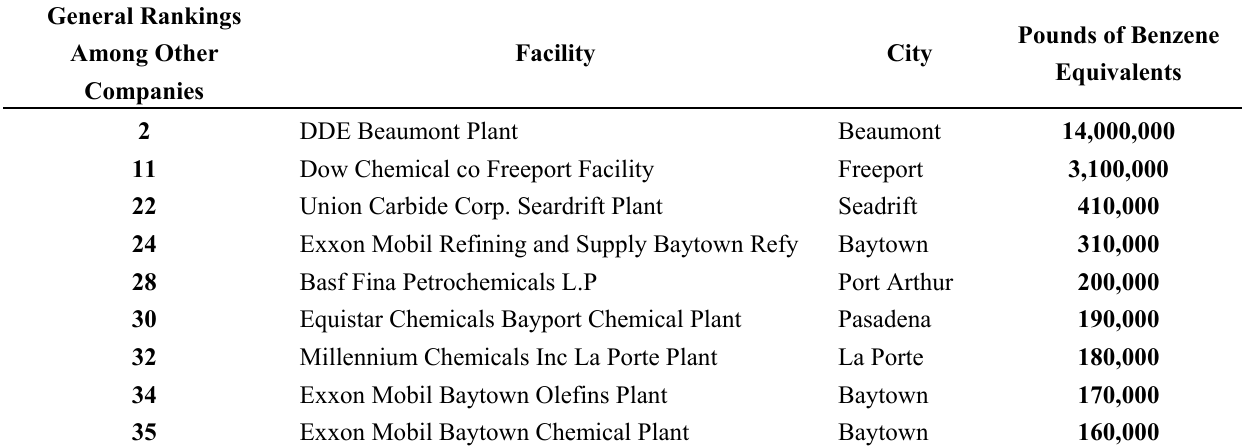
Table 9. Facilities Contributing to Cancer